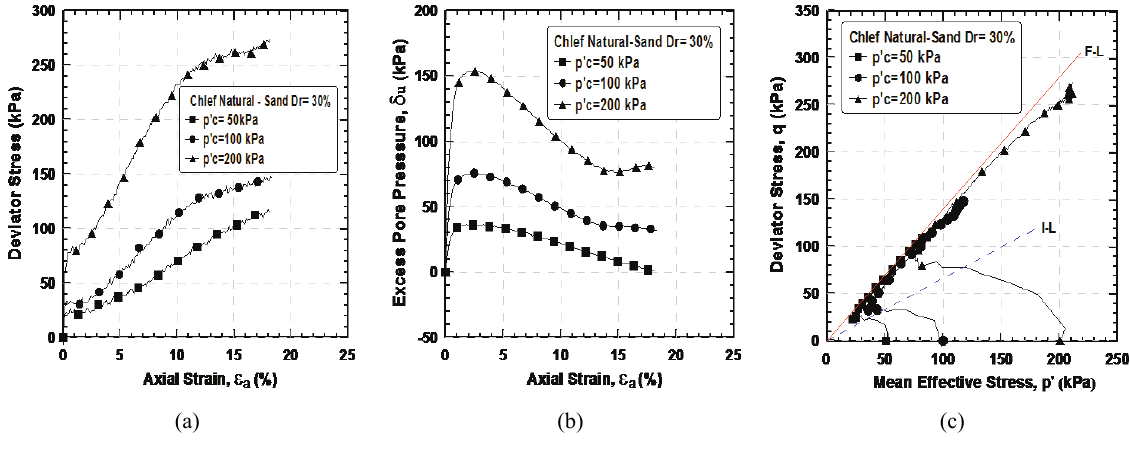
Fig. 7. Undrained response of unreinforced sand samples: